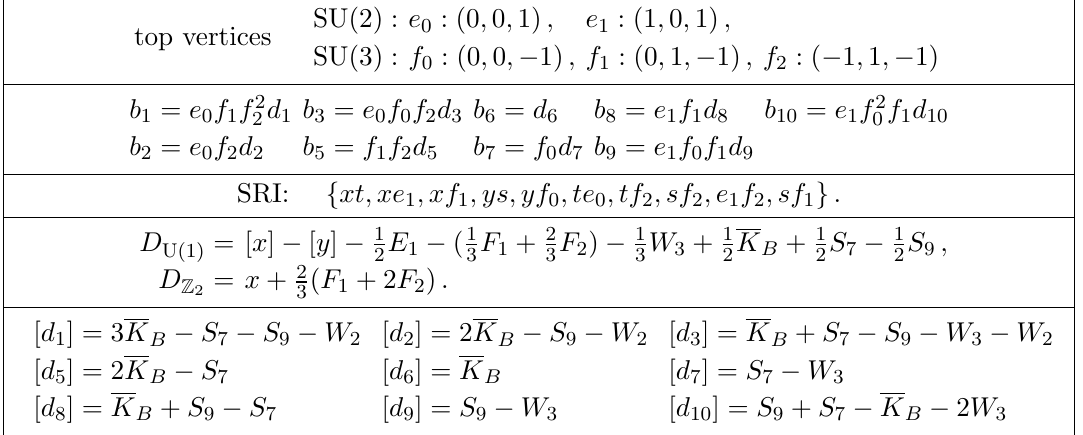
Table 5 . Geometric data for the hypersurface specialization of the second top combination.